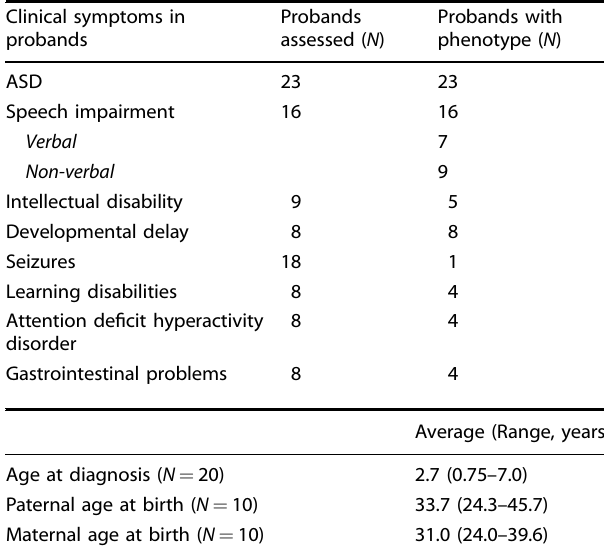
Table 1. Demographics and clinical information for the consanguineous ASD